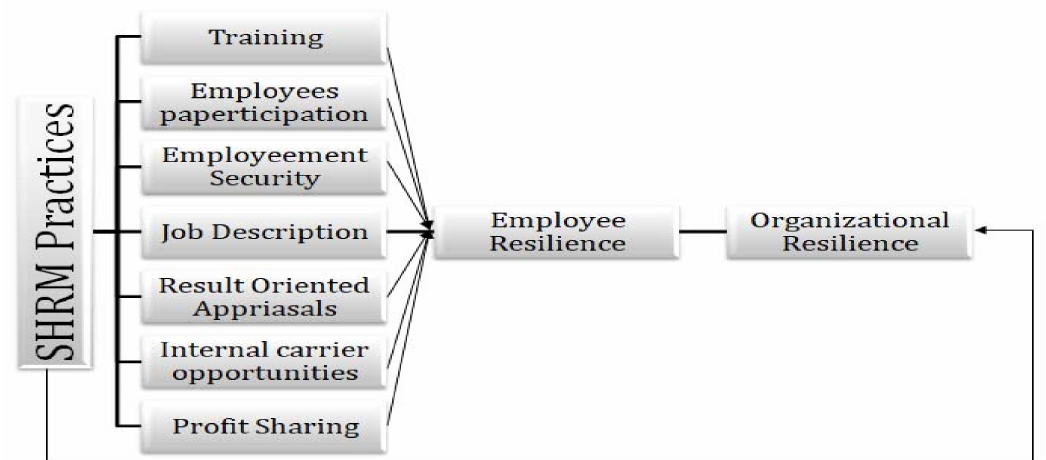
Figure 1. Research